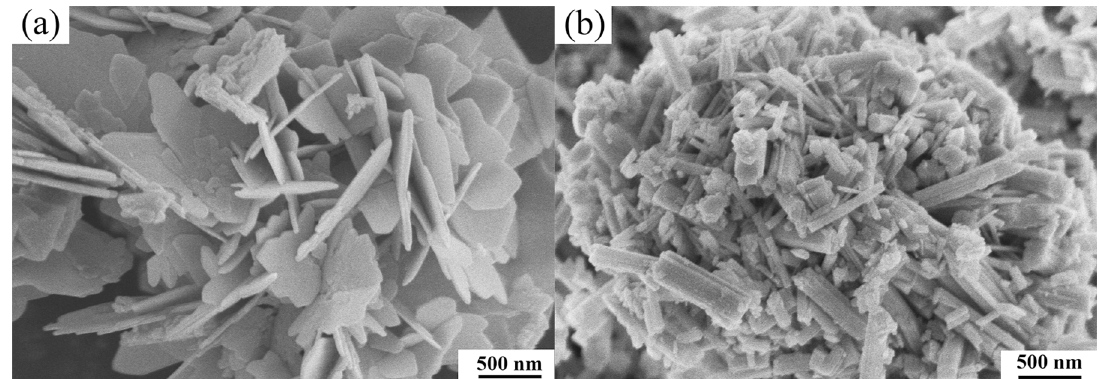
Figure 3. SEM images of samples synthesized at 350 ºC with a mass ratio of (a) 2:1 and (b) 5:1 for the salt and the precursor.